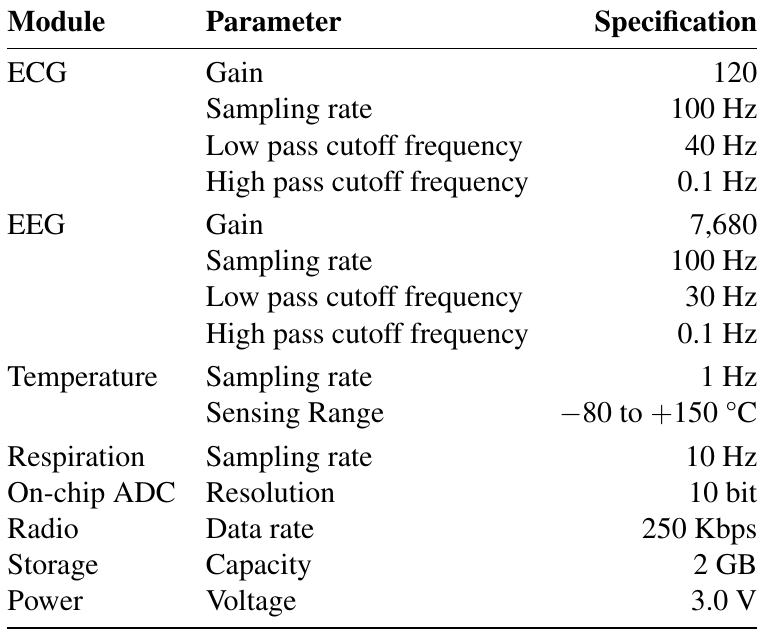
Table 1. Specifications of the sensor